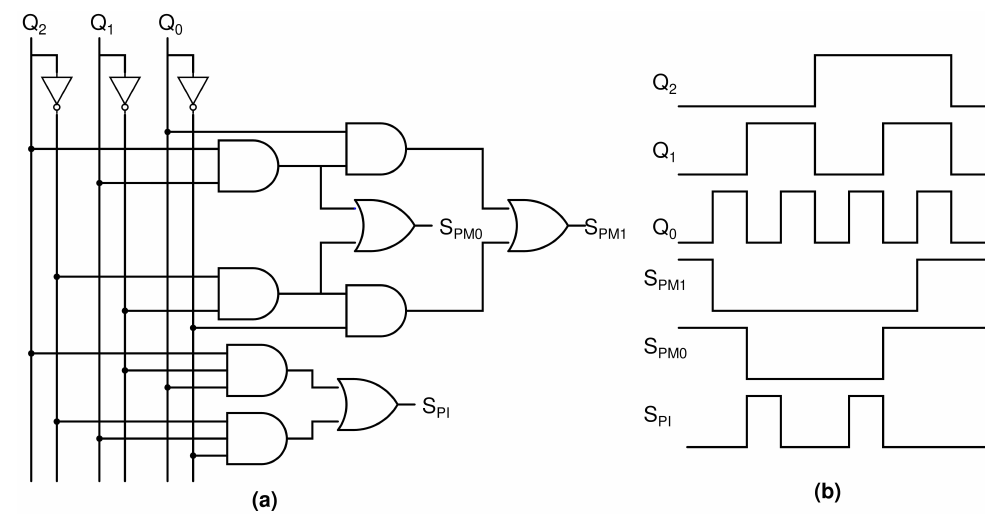
Figure 7. Adjustment control logic ( a ) Circuit configuration and ( b ) Output